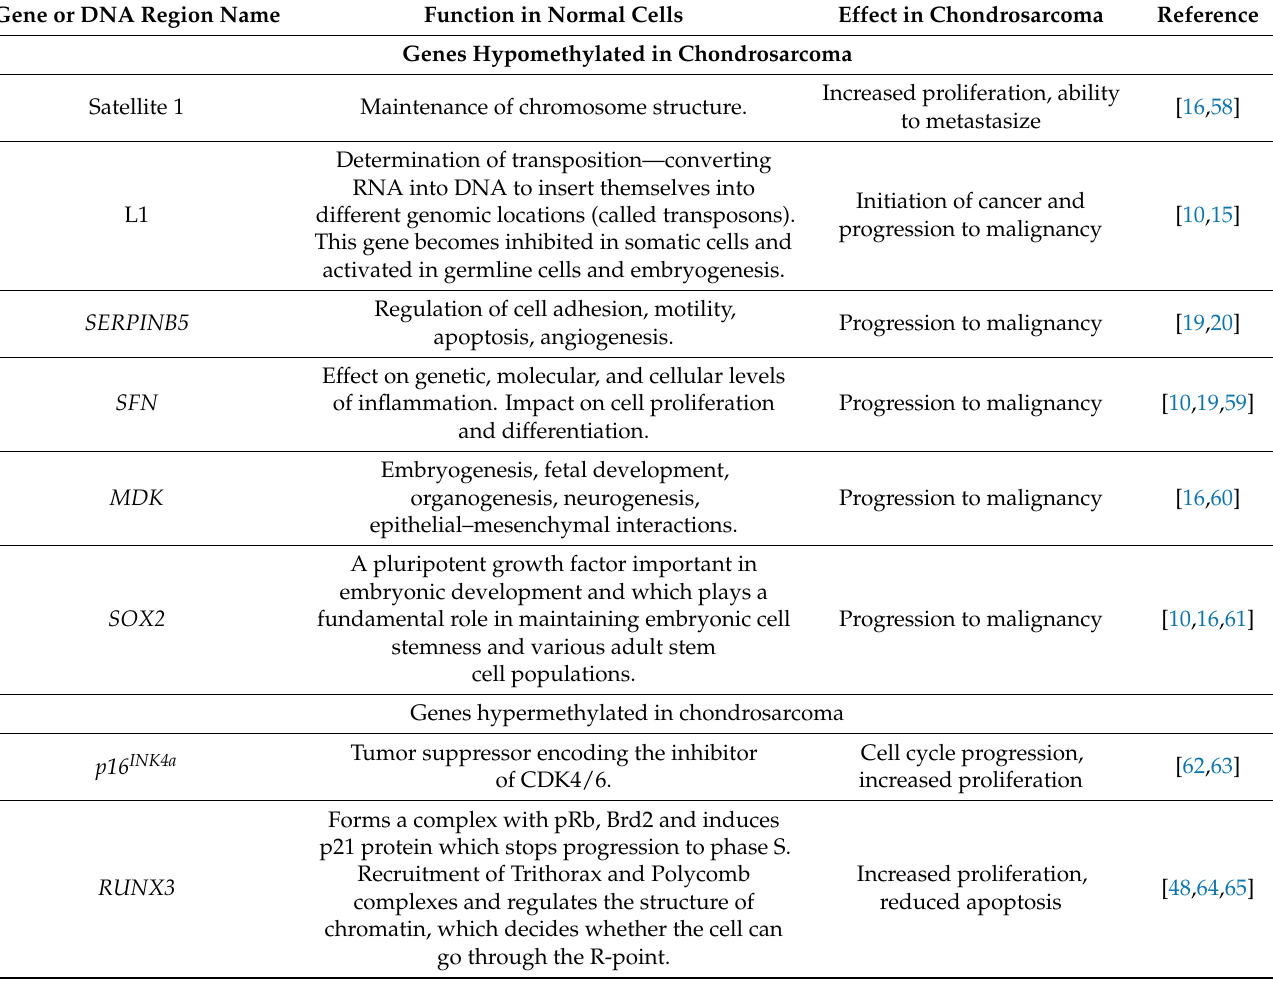
Table 1. Genes hypomethylated and hypermethylated in chondrosarcoma. Gene or DNA Region